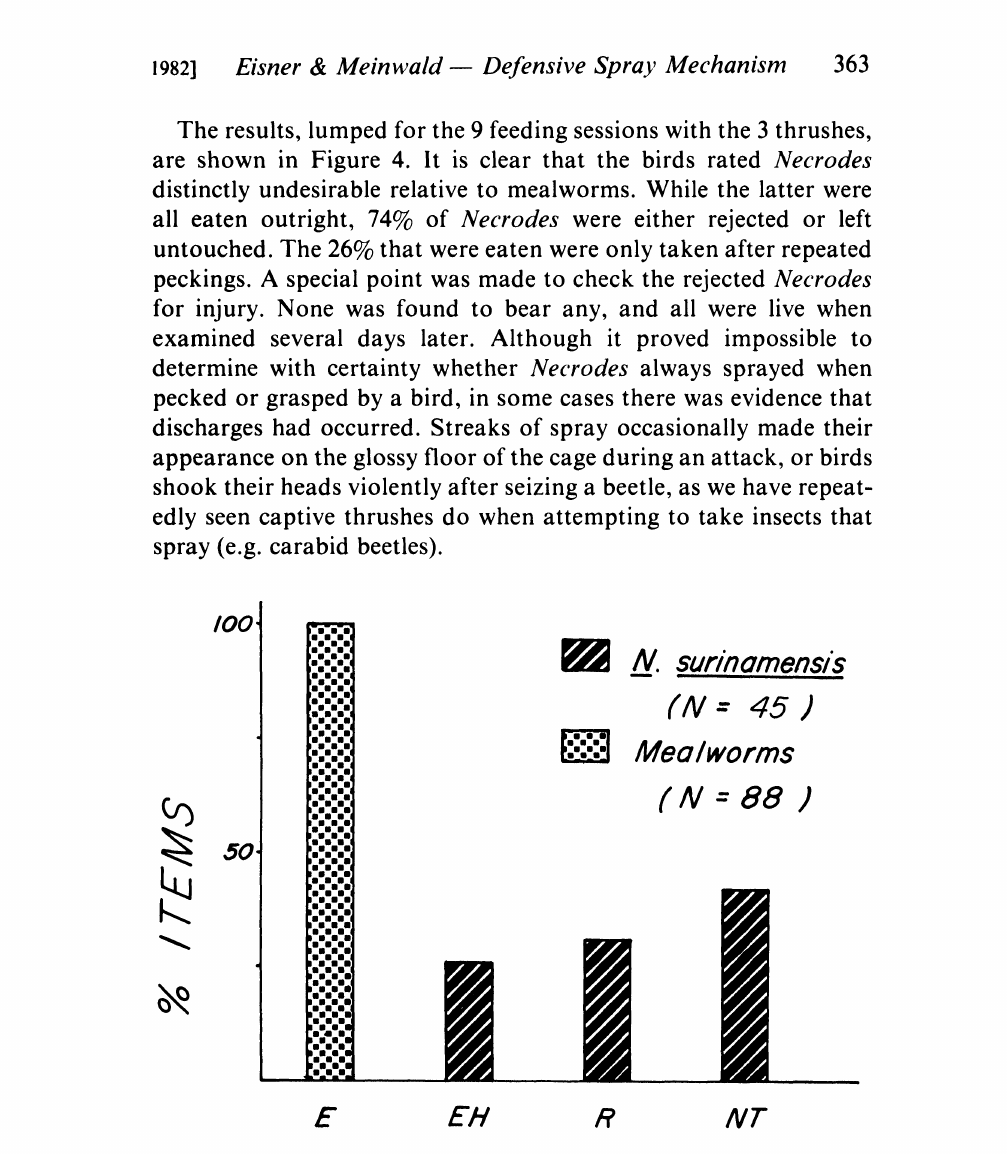
Fig. 4. Fate of Necrodes surinamensis and mealworms fed to three Swainson’s thrushes; E eaten; EH eaten with hesitation; R rejected’ NT not touched. Details in